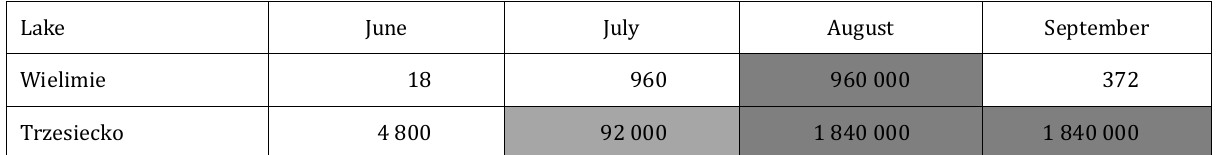
Fig. 2. Structure of a littoral zone: the example of Lake Wielimie ( M. Cichoń ) Table 1. Number of E. coli bacteria on the beach [jtk/100 ml